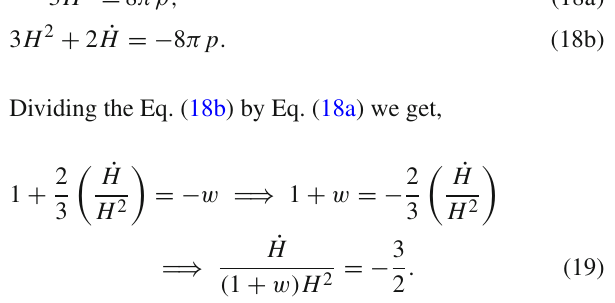
Table 1 Different entropies and corresponding dark energy densities using the standard HDE density in Eq. (7a) and Moradpour et al.’s proposal in Eq. (7b) Entropy ρ (cid:2) π ˜ r 2 A (cid:5) (cid:6) 1 + (cid:6) π ˜ r 2 A